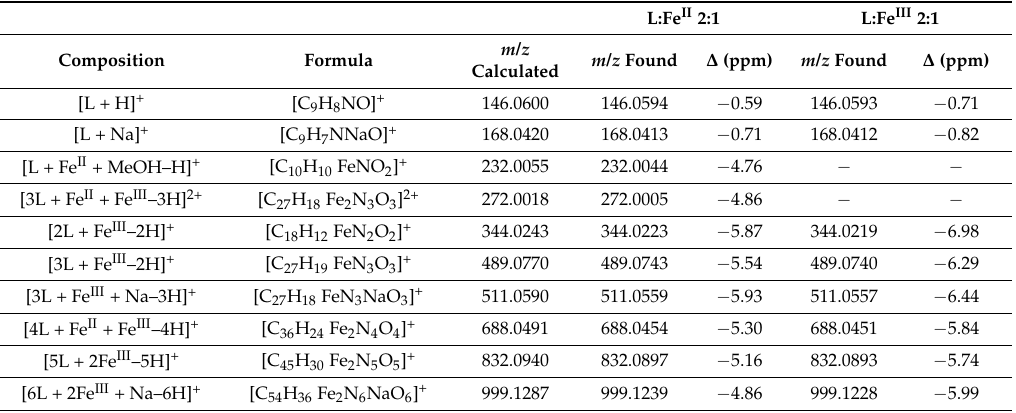
Table 1. The main signals of 56 Fe − 8HQ (L) coordination complexes in the solutions analyzed by nano-ESI − MS; a positive ionization